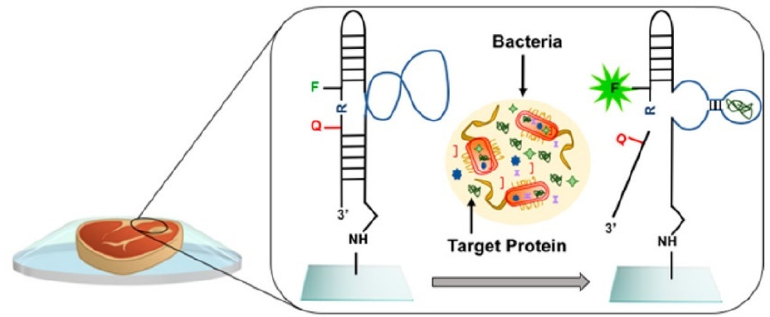
Figure 8. Representation of a sensitive DNAzyme sensor breaking up in the presence of E. coli . A transparent epoxy film supports a covalently bonded amine-terminated DNAzyme sensor. The connected fluorophor (F) and quencher (Q) are cleaved of the ribonucleotide in the presence of the target protein produced by E. coli cells. Adapted with permission from [111]. Copyright © American Chemical Society